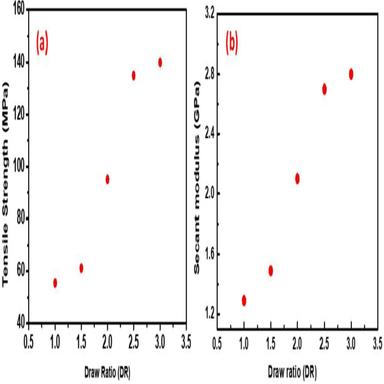
Mechanical properties of biaxially cold drawn PCTN films (a) tensile strength and (b) secant modulus as a function of DR.